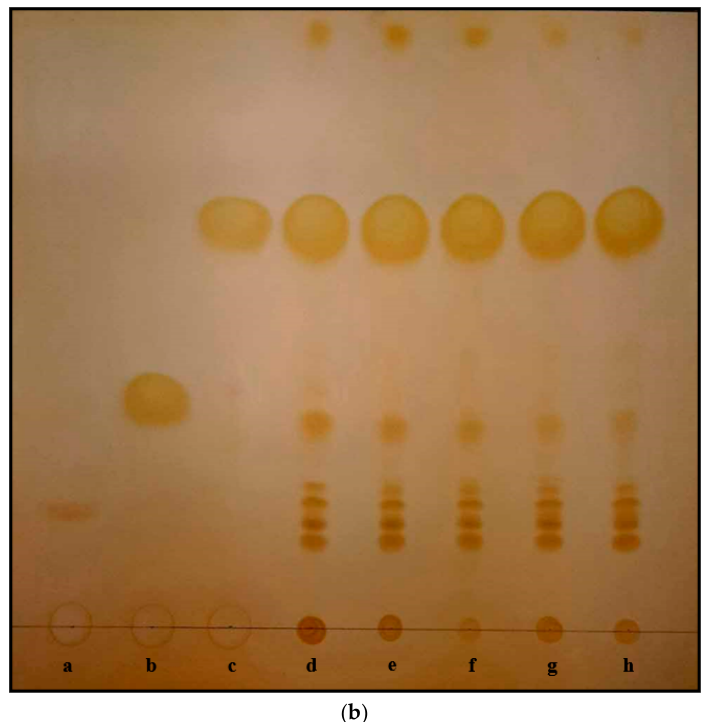
Figure 5. ( a ) Separation of neutral lipids fractions, extracted by the five strains dry biomass, cultivated in second CW through thin layer chromatography. a: triacylglycerol standard; b: free fatty acids standard; c: cholesterol standard; d: C. curvatus ATCC 20509/74 h; e: C. curvatus NRRL Y-1511/218 h; f: P. laurentii NRRL Y-2536/119 h; g: P. laurentii NRRL Y-3594/101 h; h: D . hansenii ACA-DC 5079/170 h of cultivation. ( b ) Separation of neutral lipids fractions, extracted at different time spots during the fed-batch cultivation of C. curvatus ATCC 20509, through thin layer chromatography. a: cholesterol standard; b: free fatty acids standard; c: triacylglycerol standard; d: 70 h; e: 154 h; f: 178 h; g: 257 h; h: 312 h of cultivation.